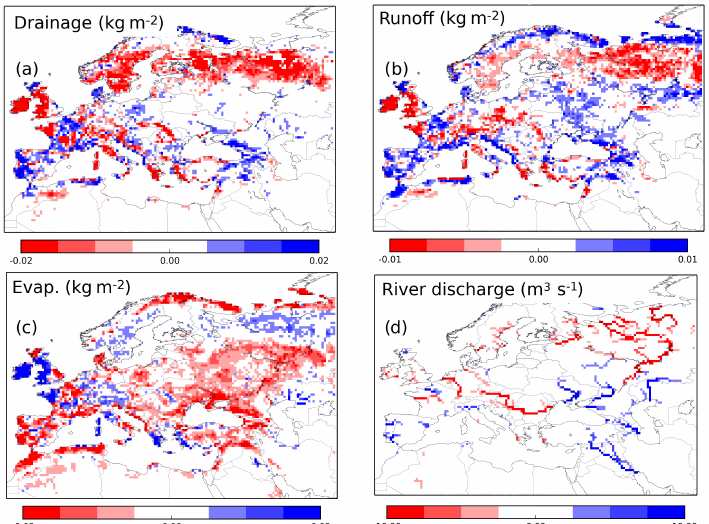
Figure 9. Averaged analysis impact on land surface variables that are indirectly affected over the period 2000–2012: (a) drainage, (b) runoff, (c) evapotranspiration and (d) river discharge.